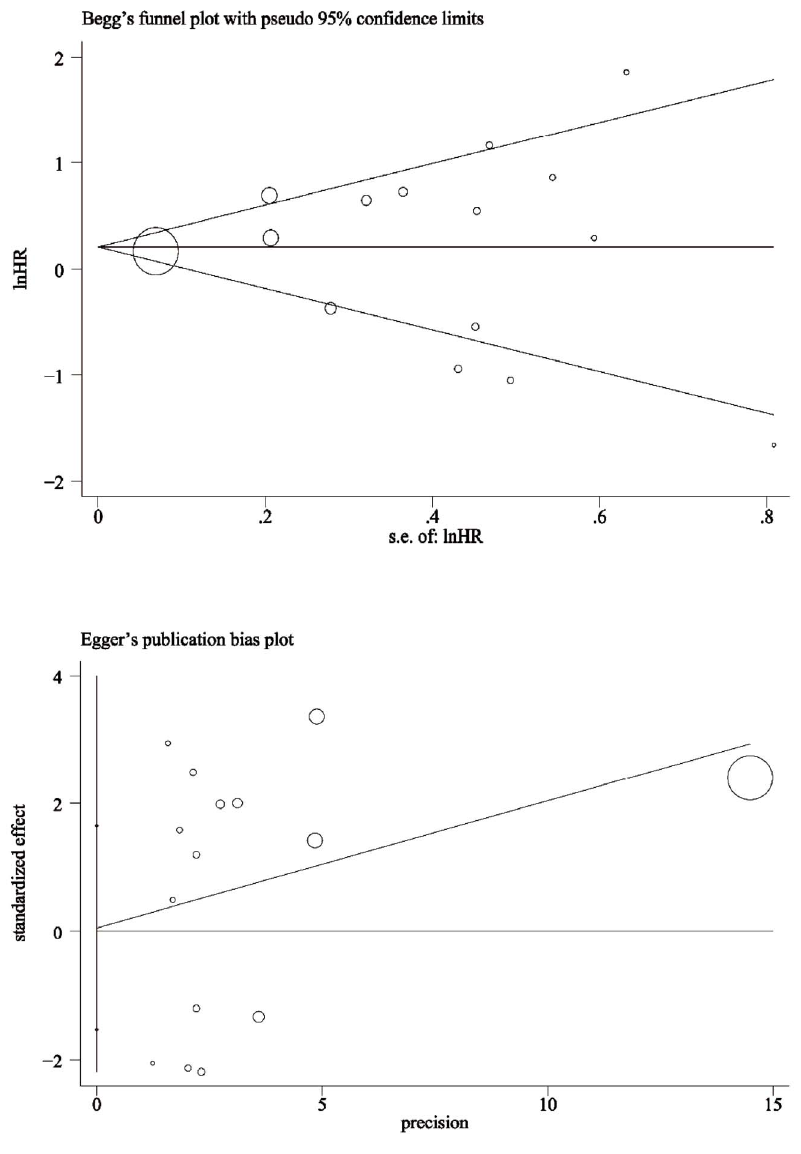
Figure 3. Funnel plots of Begg and Egger’s tests. Publication bias on overall estimation was evaluated. Studies are symmetrical distributed approximately above and below the horizontal line, and suggest the absence of publication bias in this